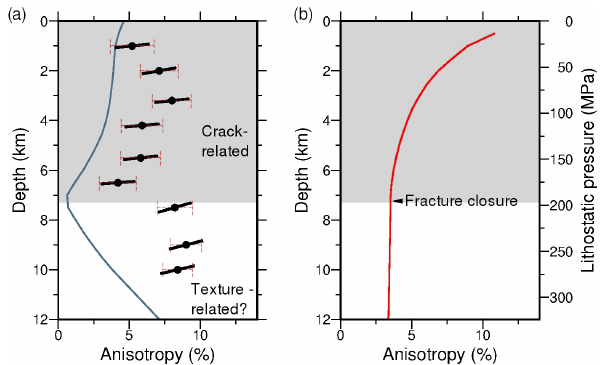
Figure 9. (a) Comparison between the absolute value of the ra- dial anisotropy magnitude measured in a representative node of the CZ (blue continuous line) and the azimuthal anisotropy esti- mations (black dots) from Acevedo et al. (2020). The orientation of the black bars depicts the azimuthal fast directions. Error bars (red dashed lines) represent 2 standard deviations of the anisotropy mag- nitude. The period–depth conversion of the azimuthal anisotropy determinations is based on the sensitivity kernels in Acevedo et al. (2019). (b) General dependence of seismic anisotropy in rocks with respect to lithostatic pressure (based on laboratory measurements of S-wave velocities obtained in high-grade metamorphic rocks from NW Spain in Brown et al., 2009). The grey area in both panels in- dicates the depths at which seismic anisotropy is controlled by the existence of open